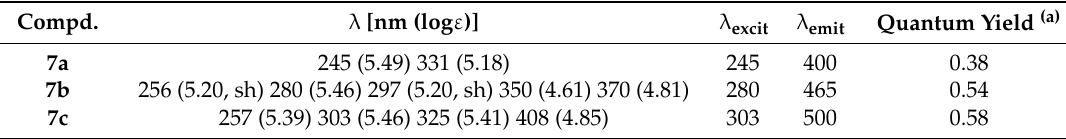
Table 2. UV absorption and FL data of compounds 7a , 7b , and 7c .